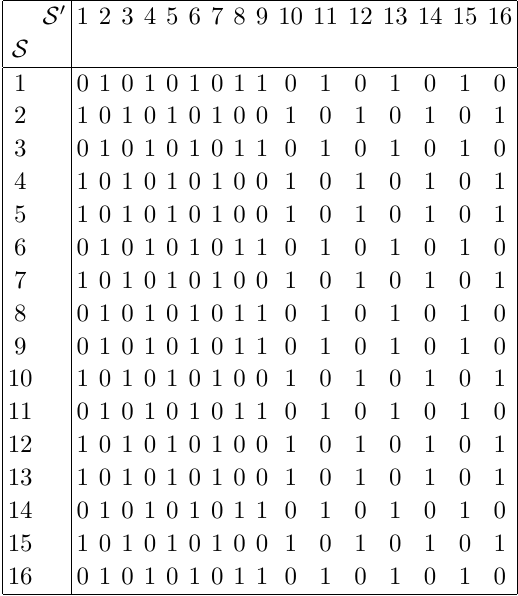
(cid:2) P with di(cid:11)erent boolean factors. [4] [6]